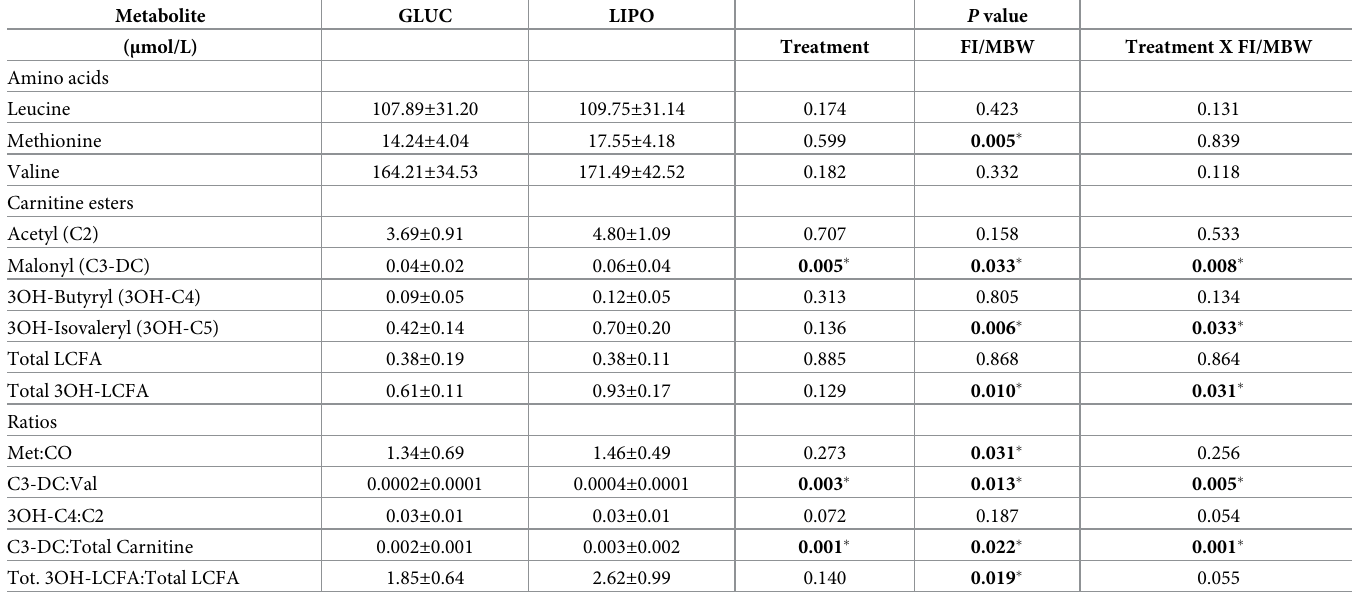
Table 3. Selected blood amino acid and acylcarnitine profiles in adult X . laevis fed isoenergetic glucogenic (GLUC) or lipogenic (LIPO) diets at varying food intakes. Metabolite GLUC LIPO P